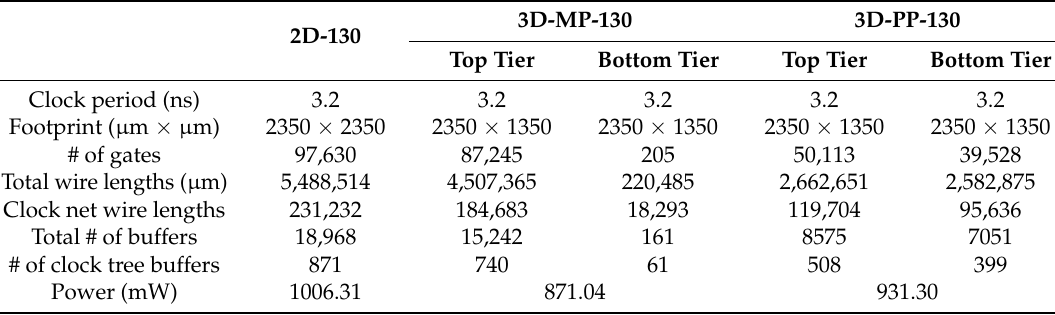
Table 6. Overall layout results of 2D and 3D ICs designed in 130-nm process technology.